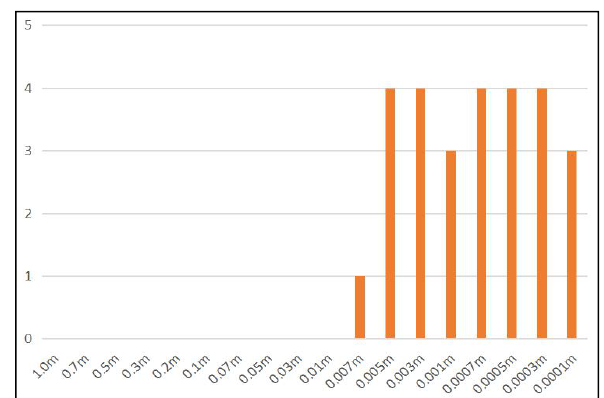
Figure 6. Geometric shrinkage technique failure